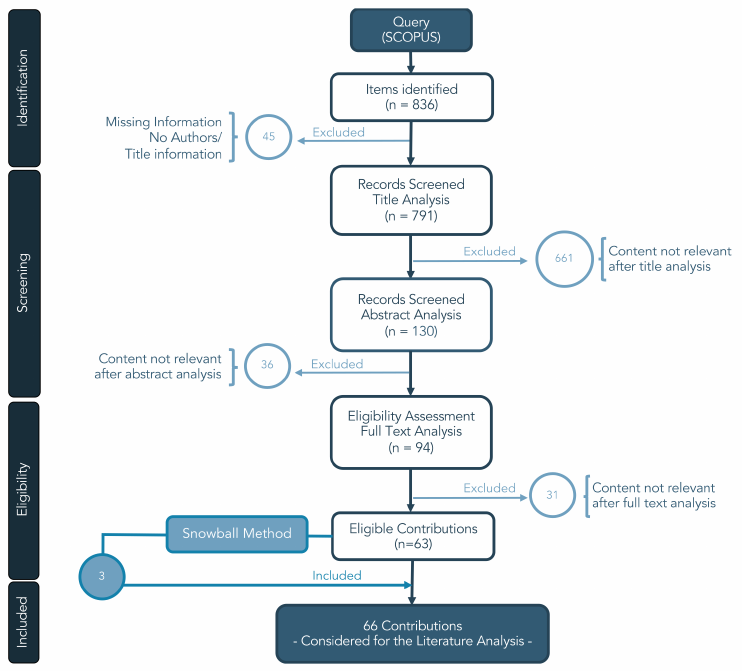
Figure 3. Preferred Reporting Items for Systematic Reviews and Meta-Analyses (PRISMA) methodol- ogy. The figure reports the different phases of the PRISMA